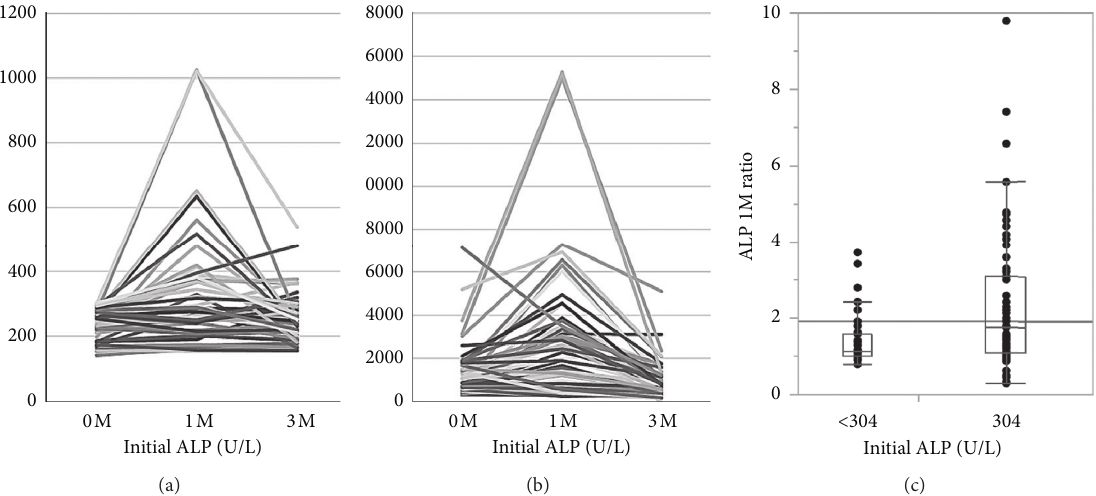
Figure 1: ALP change at 1 and 3 months after starting ADTin patients with (a) initial ALP levels less than 304 U/L and (b) initial ALP levels more than 304 U/L. (c) The ALP flare ratio was the ALP value 1 month after ADTdivided by the ALP value at diagnosis. Groups were divided according to initial ALP levels within the normal range ( < 304 U/L) or higher. The median peak ALP flare ratios were 1.11 and 1.74 in patients with an initial ALP less than 304 U/L and more than 304 U/L, respectively ( p < 0 .